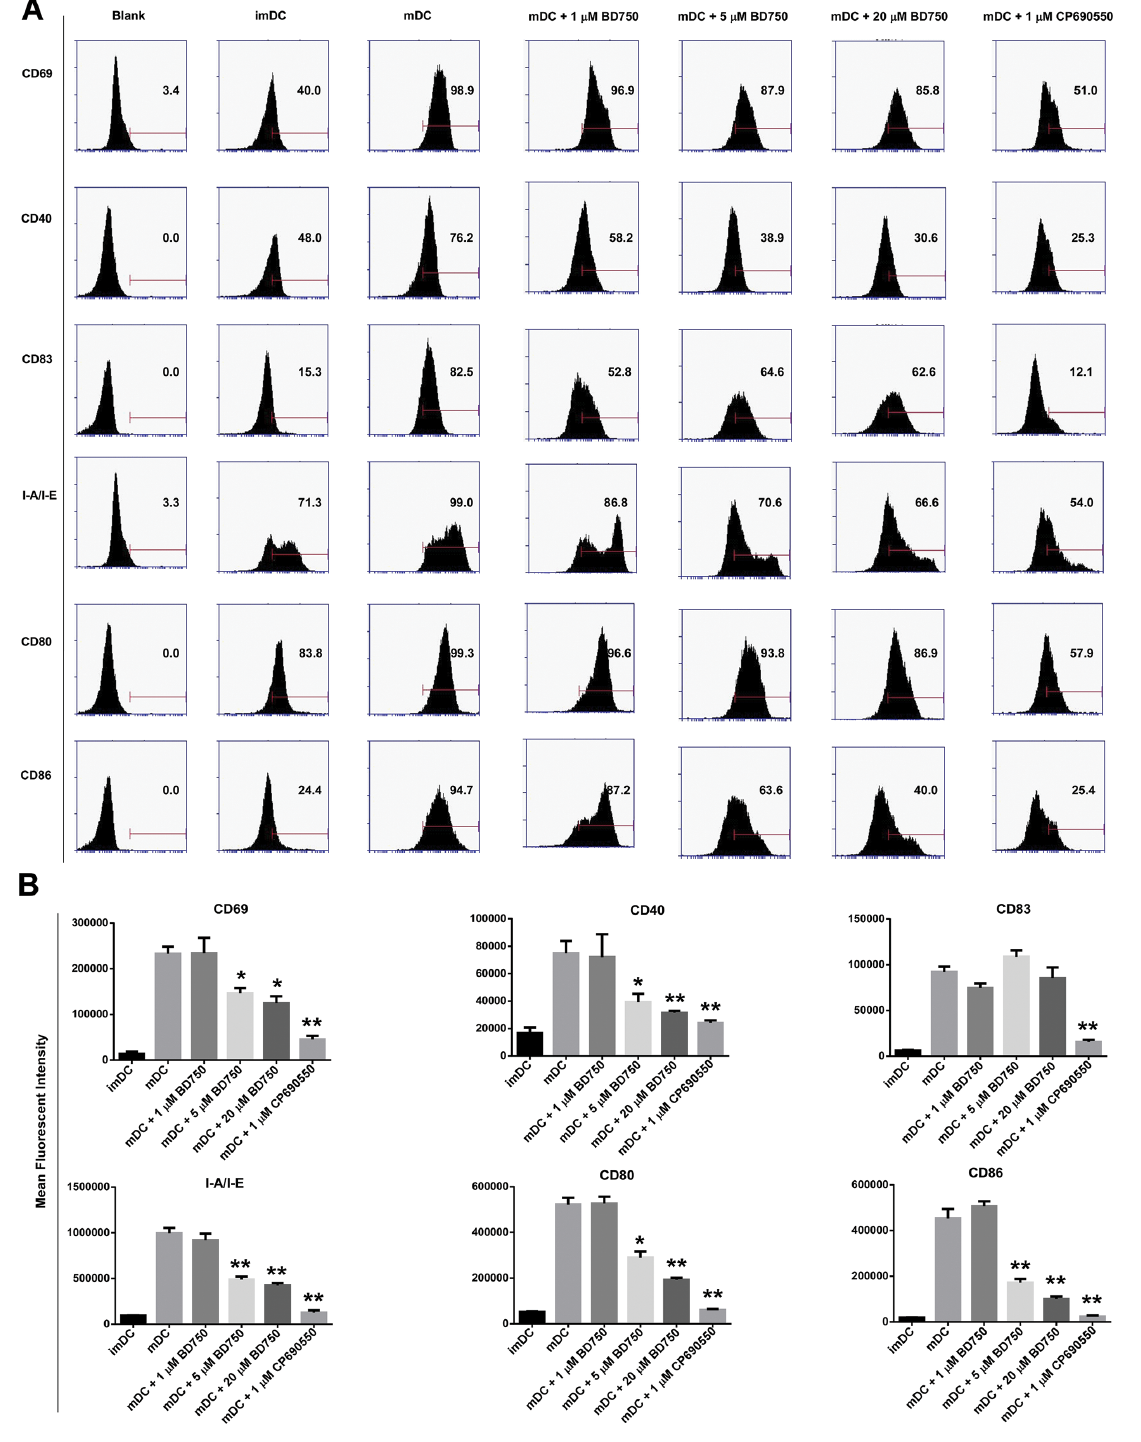
Figure 2. Analysis of maturation status of BD750-treated DCs by flow cytometry. After different treatments, the different groups of DCs were stained with the indicated antibodies and the levels of surface molecule expression were determined by flow cytometry. Data are representative histograms or expressed as the mean ± SEM of three independent experiments. (A) Flow cytometry analysis. (B) Quantita- tive analysis. * P < 0.05, ** P < 0.01 versus the mDC